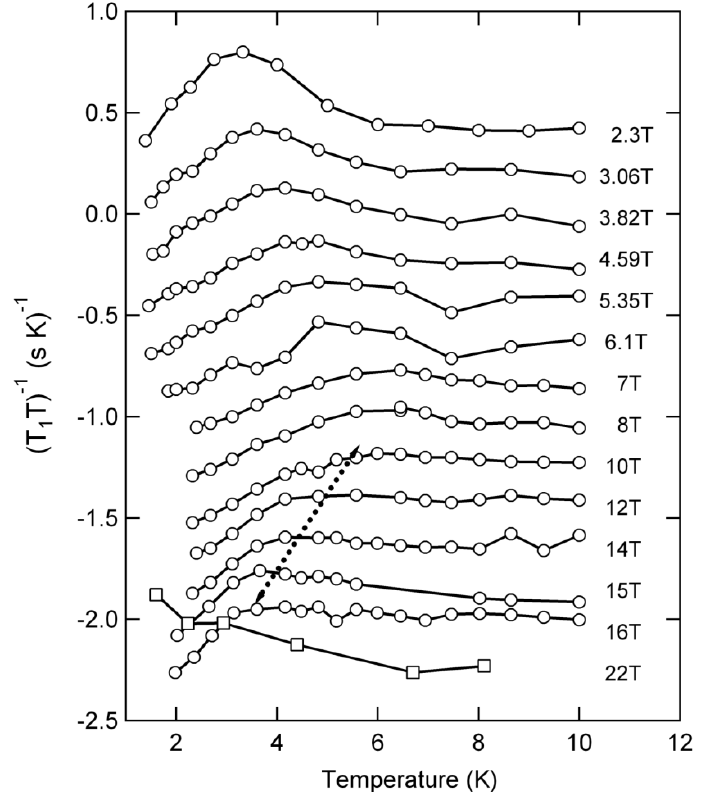
Figure 8. Summary of temperature and field dependent spin-relaxation rates of Per [Pt(mnt) ] in terms of 1/T T. Data at 2.3 T is not offset, but subsequent curves are 2 2 1 incrementally offset by −0.2 (s K) −1 for increasing magnetic field. The dashed line refers to “dog-leg” feature in the relaxation data that appears above 10